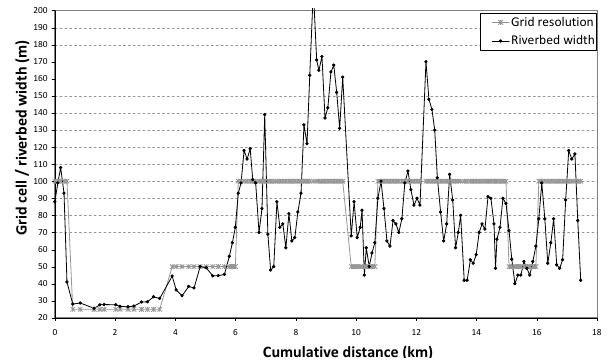
Fig. 3. Relationship among 1-D riverbed width and 2-D grid reso- lution along the Adda